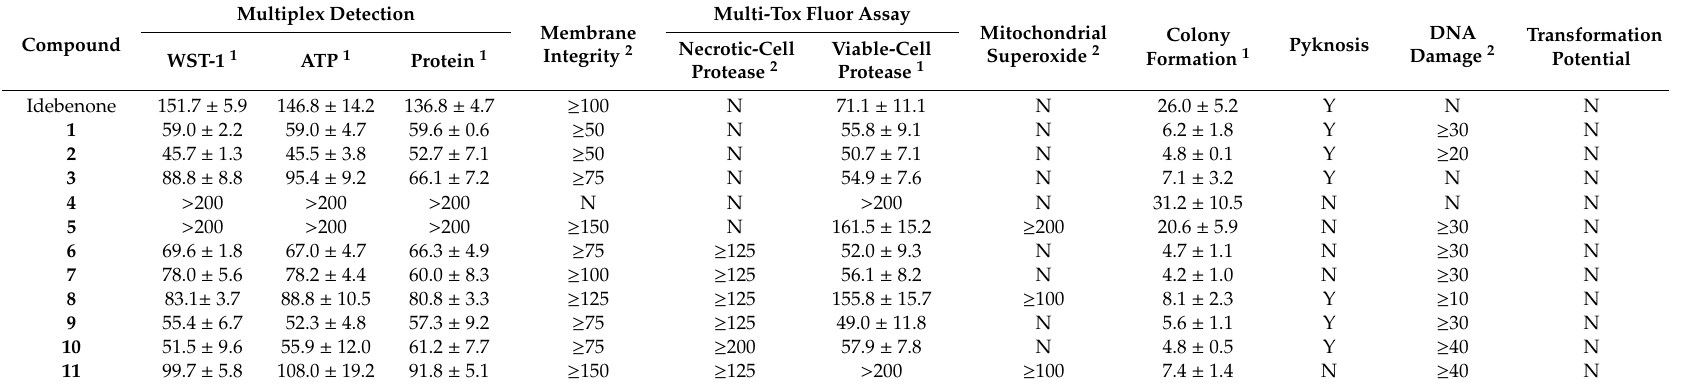
Table 2. Summary of the in vitro toxicity of